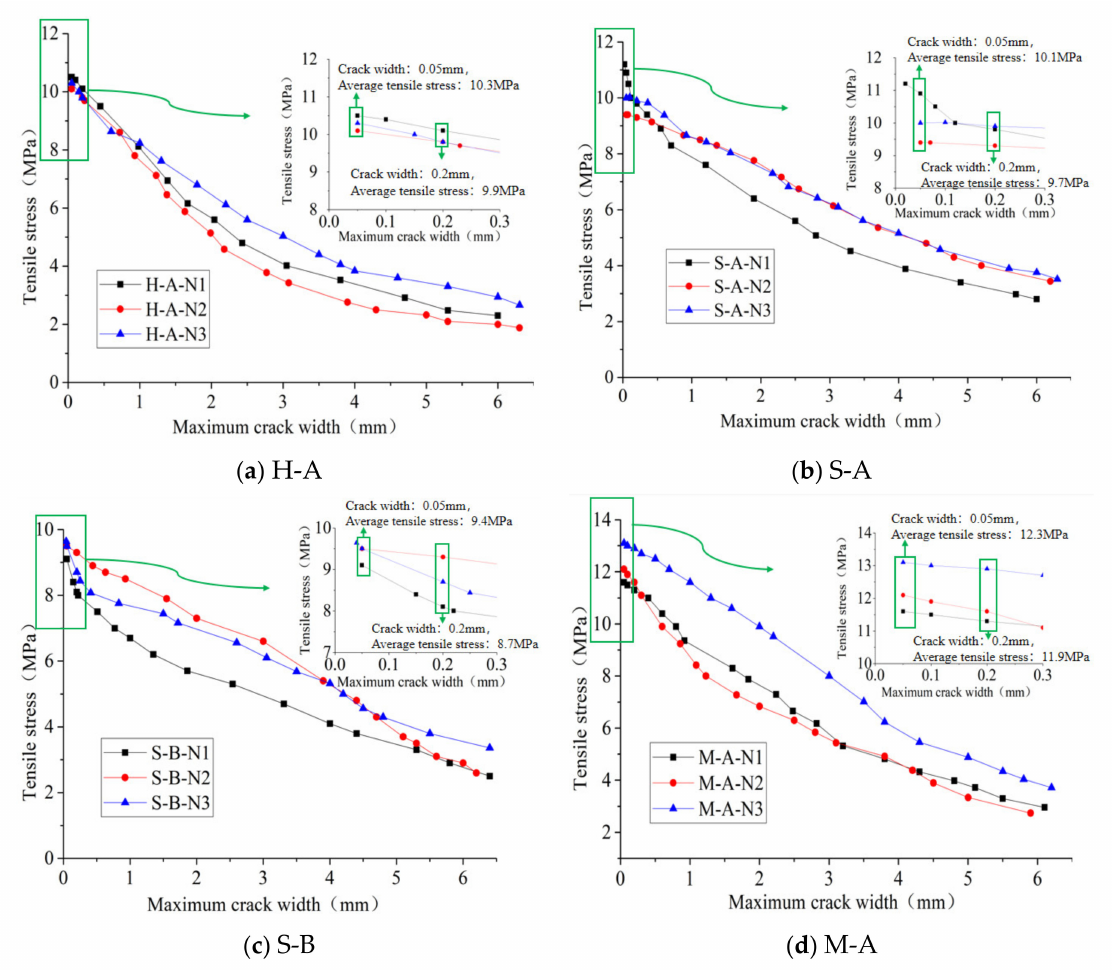
Figure 5. Direct-tensile-stress–crack-width measured curve.